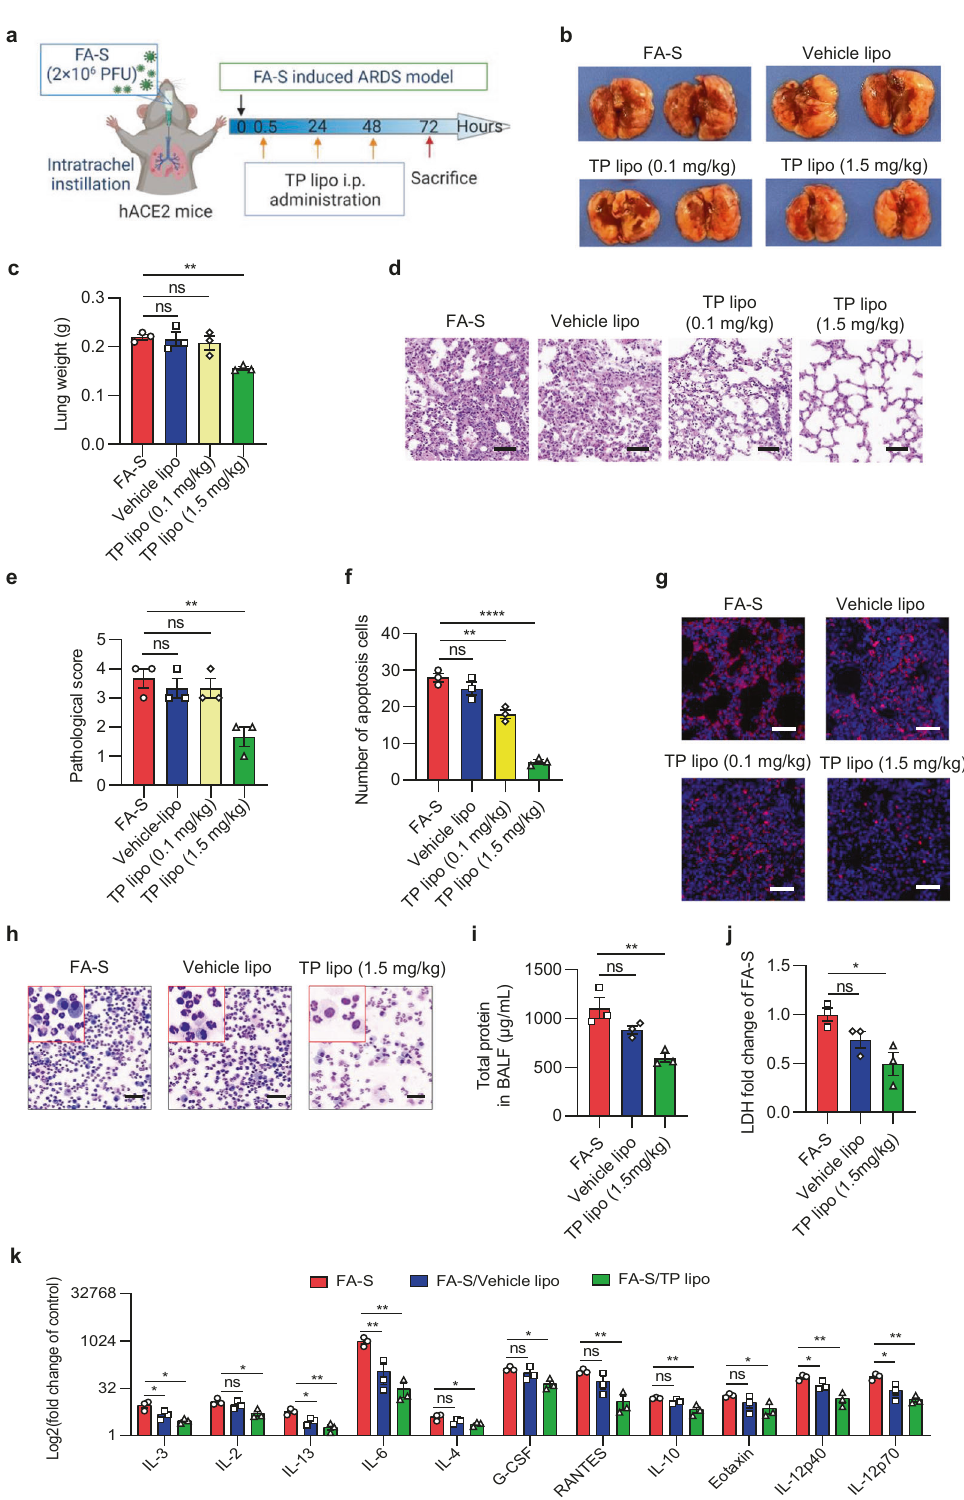
Fig. 3 TP lipo ameliorates ARDS induced by FA-S in hACE2-KI mice on a C57BL/6 J background. a Protocol of the hACE2 mouse ARDS model induced by FA-S. b , c Images of lung tissues ( b ) and changes in lung weight ( c ). d , e H&E staining ( d ) and pathological score ( e ) in representative mouse lung sections. The scale bar represents 50 μ m. f Number of apoptotic cells obtained from TUNEL staining. g Typical images of immuno fl uorescence analysis for Ly6G-positive neutrophils. The scale bar represents 50 μ m. h Typical images of cells in BALF obtained from Diff-Quik staining. The scale bar represents 50 μ m. i , j Total protein level ( i ) and fold change of LDH ( j ) in BALF. k Comparison of key proin fl ammatory cytokine responses in FA-S infection compared with Vehicle lipo and TP lipo. The results are presented as log2 of the fold change of the control. Data represent the mean ± SEM; n = 3. Signi fi cance is indicated by: ns no signi fi cance; * P ≤ 0.05; ** P ≤ 0.01; **** P ≤ 0.0001